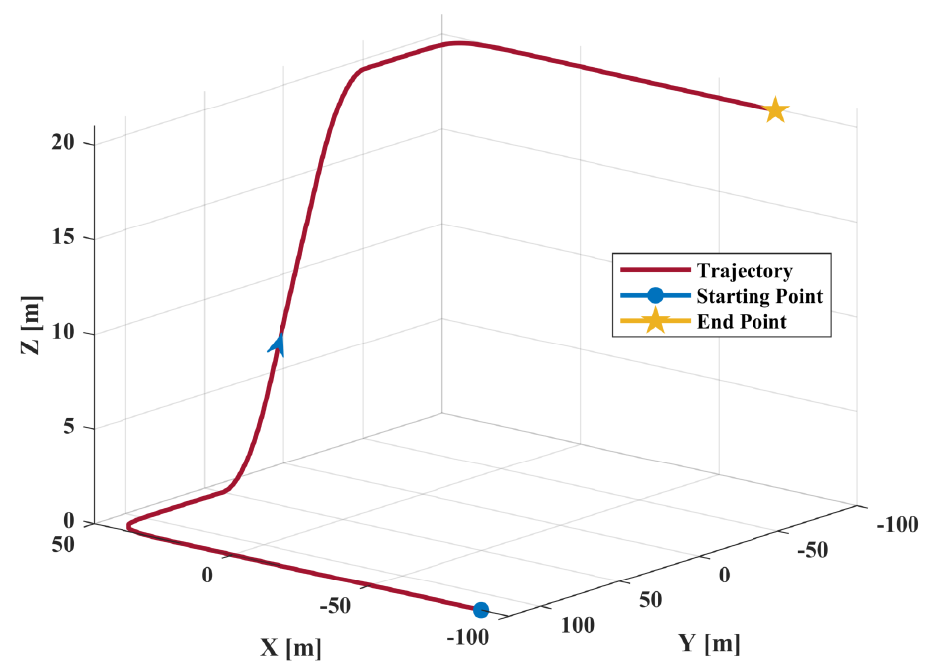
Figure 7. Reference